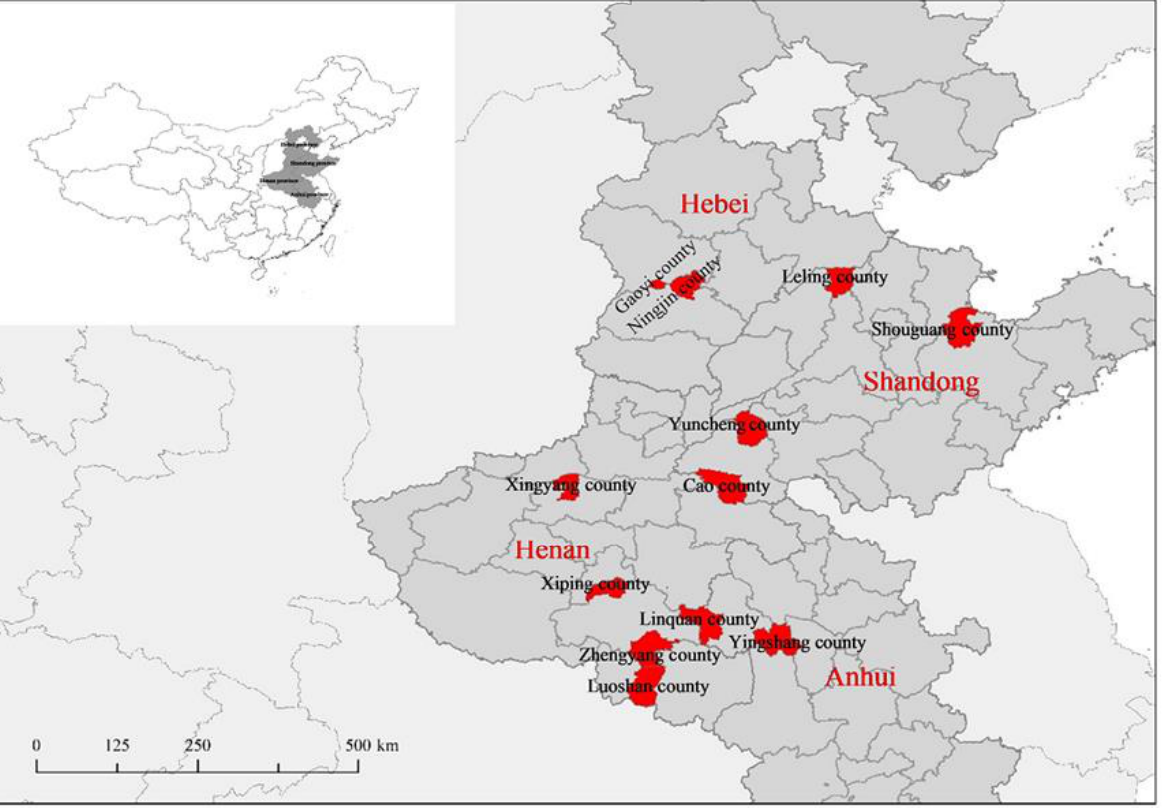
Figure 1. The sample distribution of 12 counties in four main grain production provinces (Total sample size = 960).